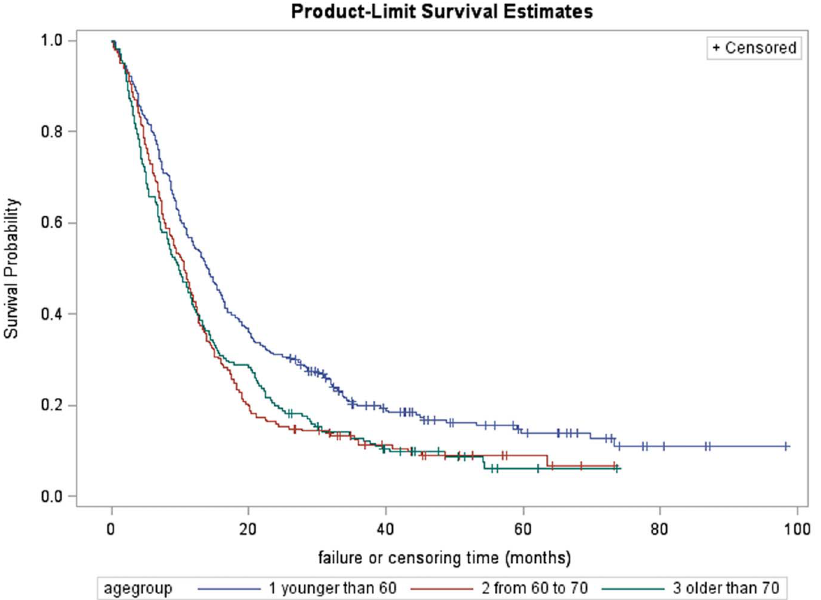
Figure 3. the survival rate of pancreatic cancer patients among Shanghai residency underwent surgical resection, Shanghai Cancer Registry 2004 – 2009. Age , 60: 1-year survival rate 54.8%, 3-year survival rate 19.8%, 5-year survival rate 13.9%, Age , 70: 1-year survival rate 42.3%, 3-year survival rate 11.2%, 5-year survival rate 6.7%, Age . 70: 1-year survival rate 40.8%, 3-year survival rate 12.3%, 5-year survival rate 6.2%.